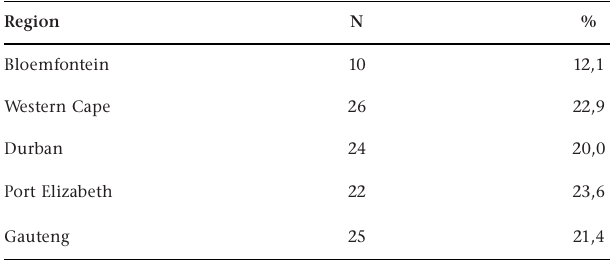
Table 2 sets out the biographical information for the